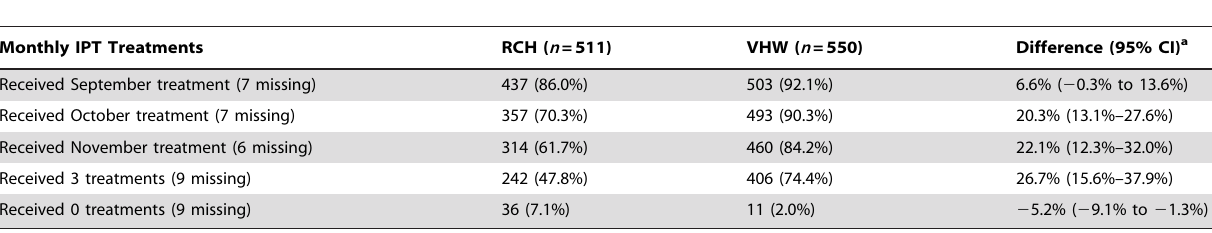
Table 2. Coverage of monthly IPT treatments achieved with delivery of IPTc by RCH trekking teams or by VHWs.